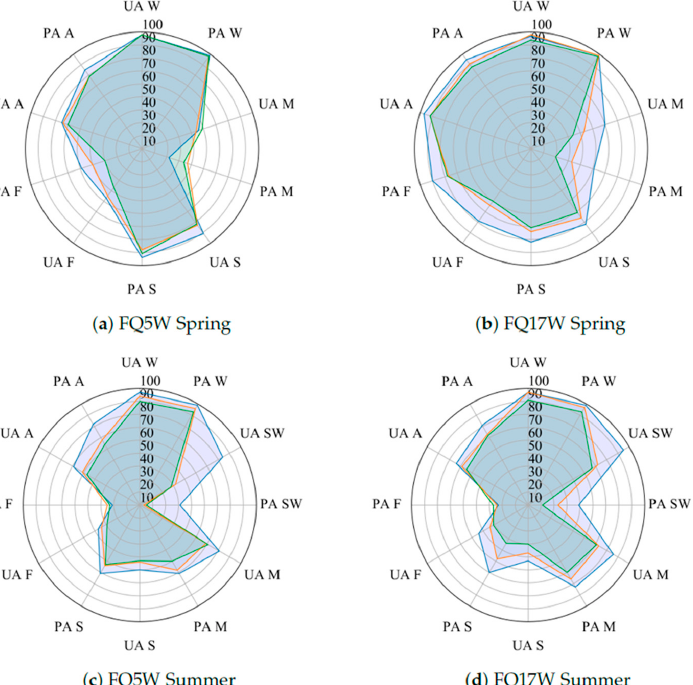
Figure 11. User’s (UA) and producer’s (PA) accuracies for water (W), shallow water (SW), marsh (M), swamp (S), forest (F), and agriculture/non-forested (A) for models based on single QP (blue), CP medium (orange), or CP high resolution (green) images for classifications using ( a )spring image collected at steep incidence angle, ( b ) spring image collected at shallow incidence angle, ( c ) summer image collected at steep incidence angle, and ( d ) summer image collected at shallow incidence angle. For models based on single SAR images, those constructed with the simulated RCM CP data achieved significantly lower accuracies than those constructed with RADARSAT-